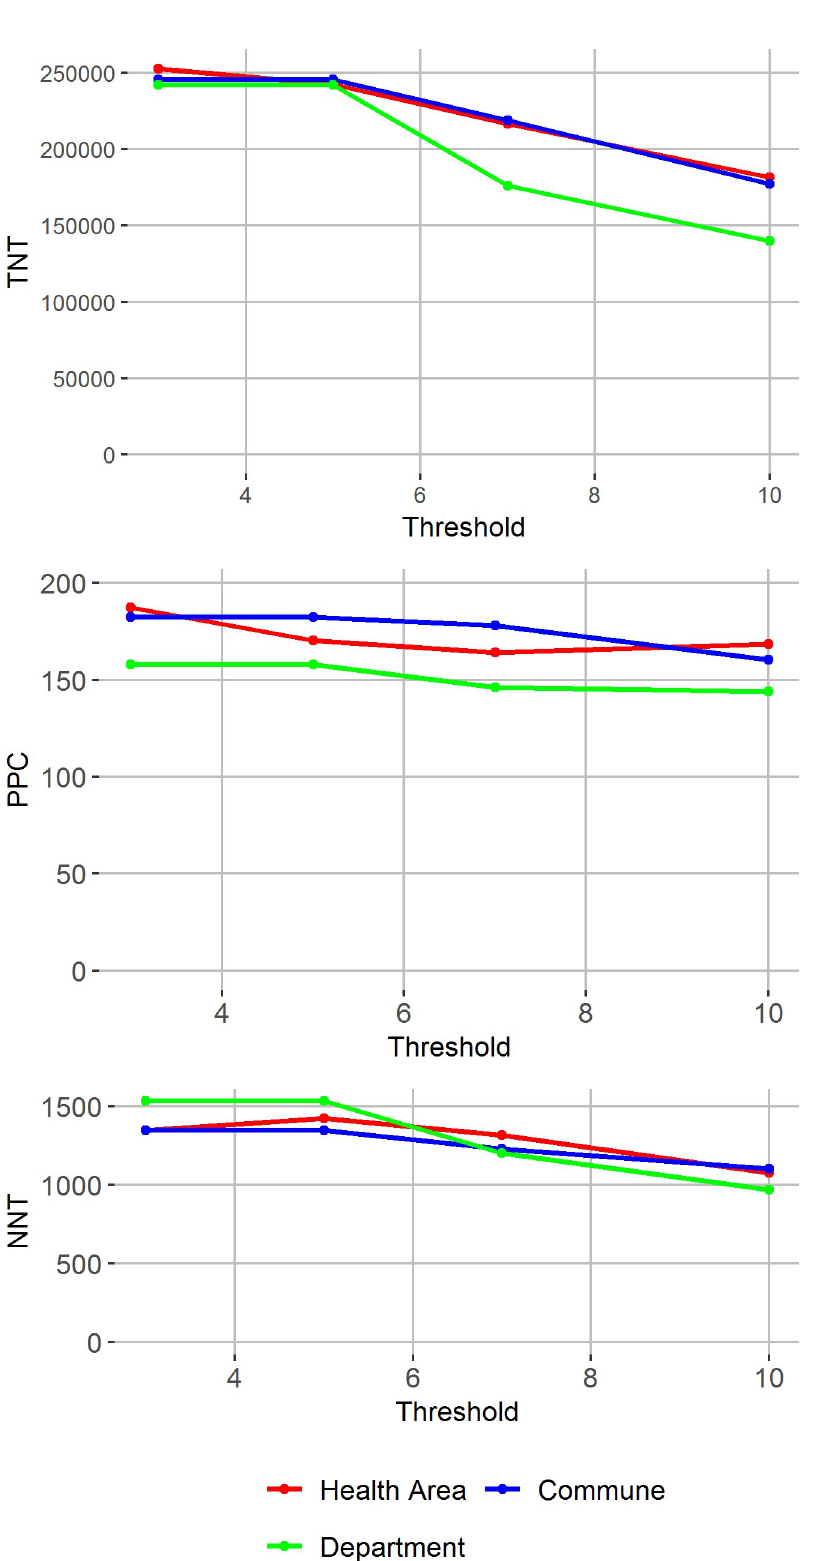
Fig 3. Potential effectiveness and efficiency of village-prophylaxis strategies by epidemic threshold definition. Total number treated, potentially prevented cases (PPC) and number needed to treat per PPC from applying a village- prophylaxis strategy, varying the threshold for intervention, with surveillance at different spatial units (colors).